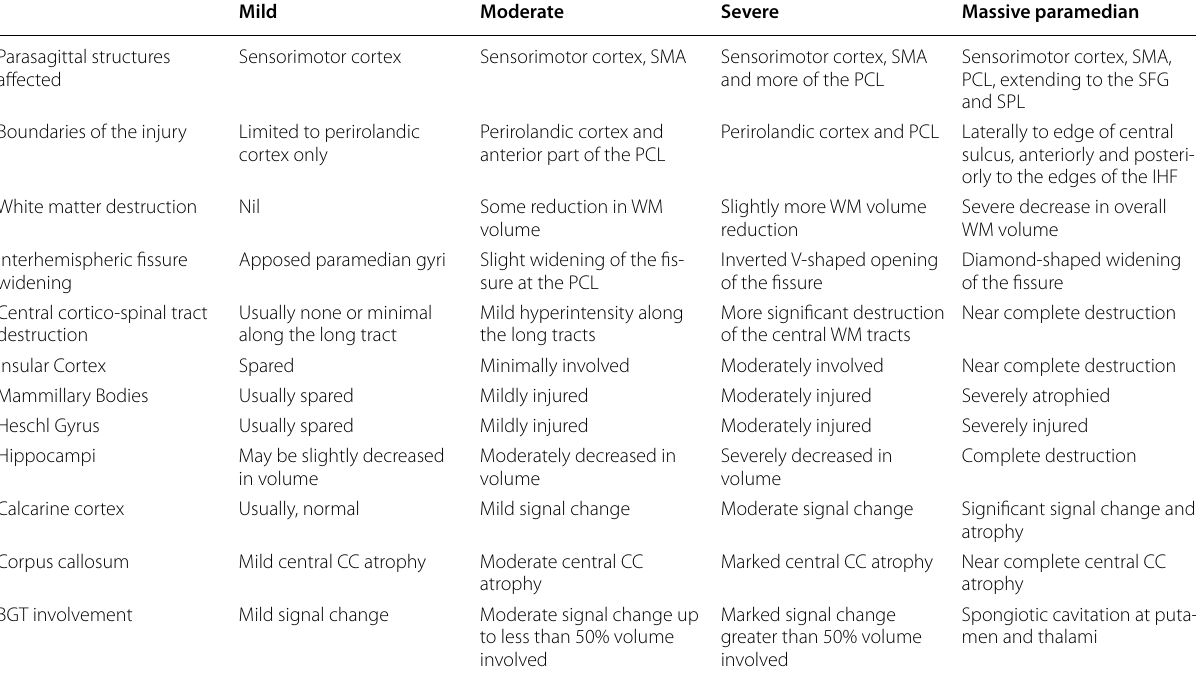
Table 2 Key features of each subtype of parasagittal central hypoxic–ischaemic